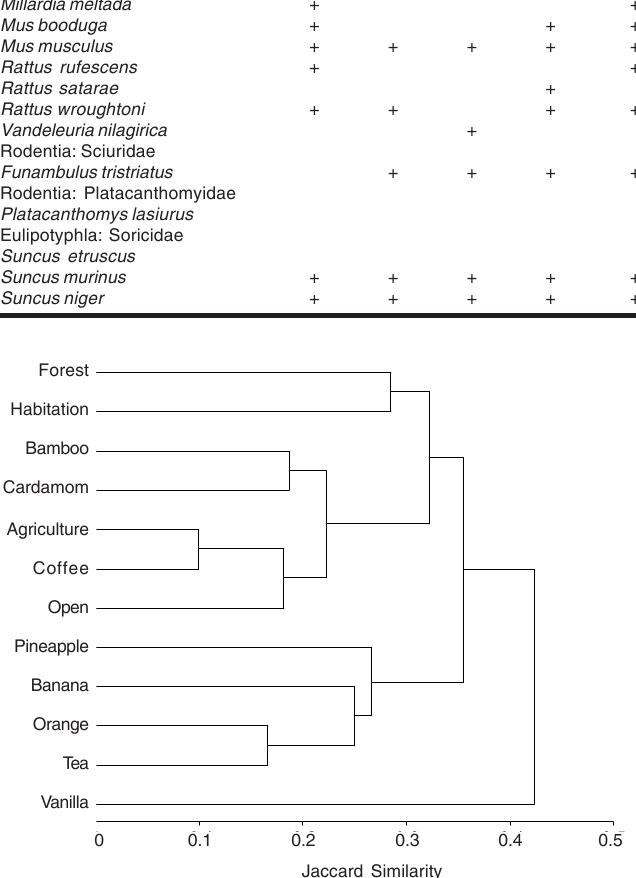
Table 2. Small mammals trapped in different habitats in Coorg Taxon Agri Rodentia: Muridae Bandicota bengalensis